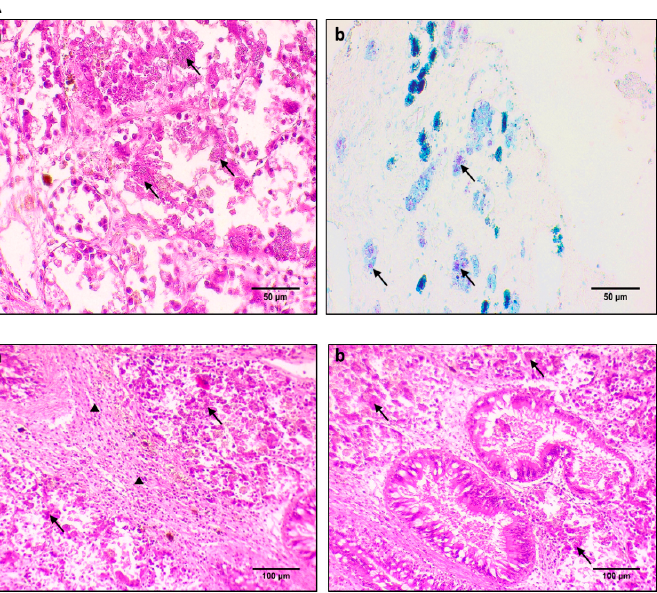
Figure 2. Histological sections of P. nobilis , showing sporulation stages of H. pinnae and Mycobacte- rium sp. in the digestive gland of infected animals. ( Aa ) Sporulation stages of H. pinnae (arrows). ( Ab ) Gram-positive acid-fast mycobacteria (arrows) on sections stained with ZN staining. ( Ba ) Dif- fuse type inflammation in digestive gland of infected specimens with H. pinnae (arrows) and heavy haemocyte infiltration in the surrounding connective tissue (triangle). ( Bb ) Display of heavy lesions in the digestive gland of infected animals with the presence of H. pinnae (arrows). Regarding the detection of the proteins examined in this research, Western blotting, dot blotting, and IHC techniques were employed to quantify and localize the expression between the individuals infected by both parasites and the individuals infected only by Mycobacterium sp. IHC results showed different expression patterns in each protein in the digestive gland tissue examined for this research. Labeling of primary antibodies was ob- served as brown precipitates (indicated by black arrows), the product of DAB (3,3 ′ -Dia- minobenzidine) chromogen. In general, no differences were observed in the expression and localization of the proteins observed as a result of IHC between the individuals in- fected only with Mycobacterium sp. and the individuals infected by both pathogens. Hsp70 was localized, in both cases, mostly in the epithelial cell of the digestive gland and less on the connective tissue (Figure 3(Ba,Bb)). In contrast, Western blot analysis in- dicated that individuals additionally infected by H. pinnae exhibited higher levels of both Hsp70 and Hsp90 in all three examined tissues, compared to the non- H. pinnae -infected individuals, as depicted in grey shaded areas in Figure 3A.